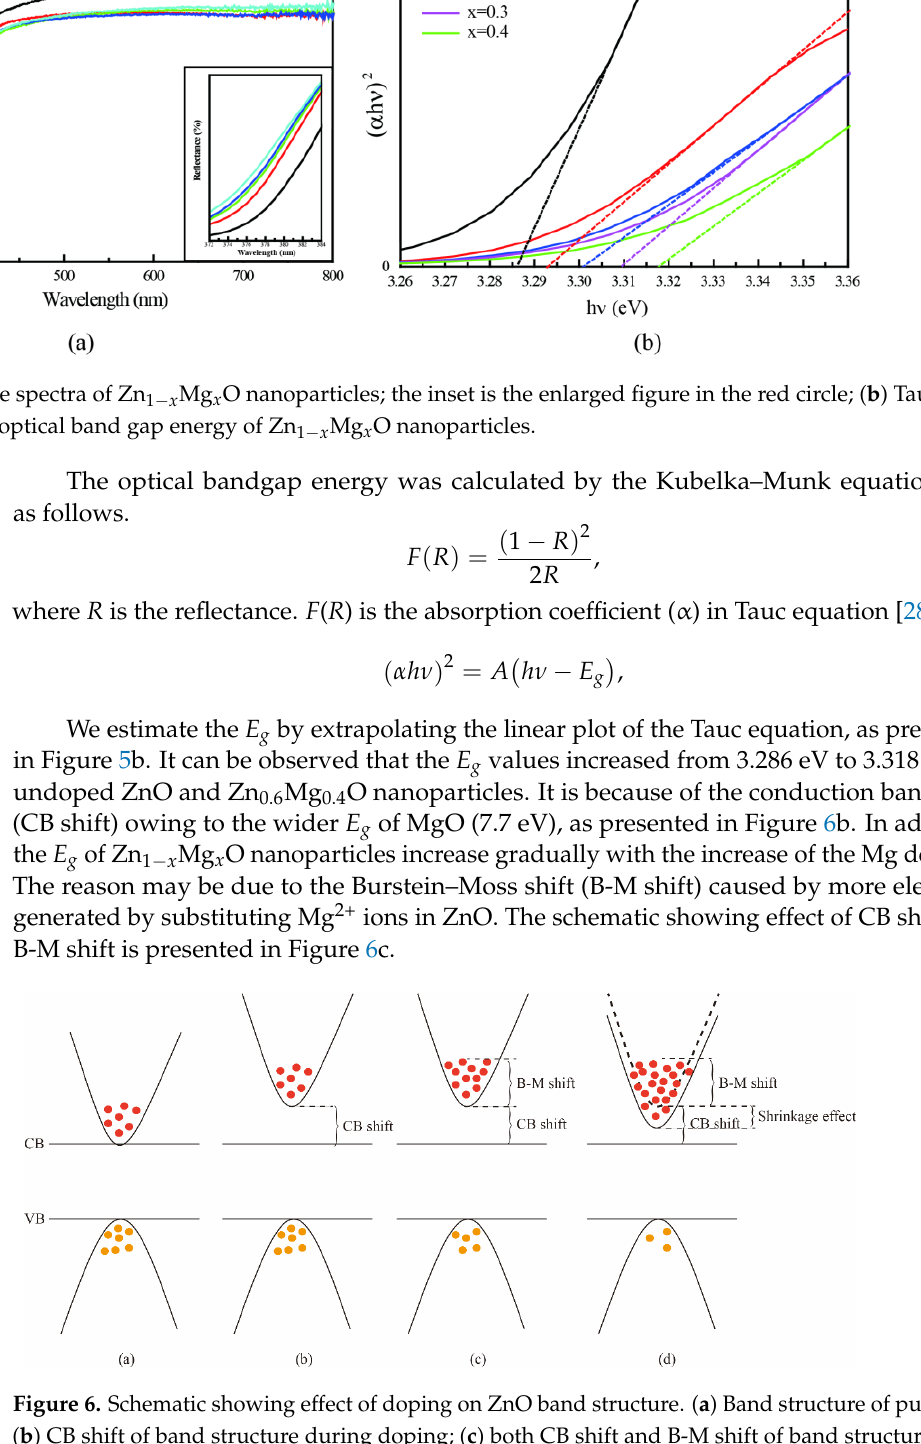
Figure 7. Band gap energy E g of pure and doped ZnO nanoparticles. ( a ) Zn 1− x Mg x O; ( b ) Zn 1−0.02− x Mg x B 0.02 O; ( c ) Zn 1−0.04− x Mg x B 0.04 O. 4. Conclusions The pure and doped ZnO nanoparticles were successfully synthesized by a simple one-pot method. XRD results show that both Mg and B are incorporated into the ZnO lattice without changing the original wurtzite structure of ZnO. By introducing Mg ele- ment into ZnO nanoparticles, the lattice parameter is increased. However, the B element increases the lattice strain and dislocation density, thereby decreasing the crystallite size. Combined with the analysis of the microstructure, it can be seen that Mg ions promote the crystallization of ZnO, while B ions make the crystallinity worse. The influence of doping Mg and B on the band structure is also investigated. The results show that the E g of ZnO nanoparticles increase with doping Mg, while that of B-Mg co-doped ZnO increases first and then decreases due to the competition of CB shift, Burstein–Moss shift and Shrinkage effect. Author Contributions: Y.L. (Yongli Li): methodology, formal analysis, and data curation. Y.L. (Yuechan Li): conceptualization, investigation, writing—original draft preparation. A.X.: writing— review and editing, funding acquisition. All authors have read and agreed to the published version of the manuscript.